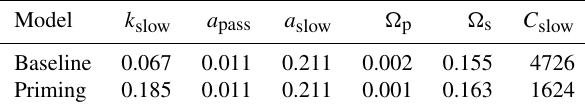
Table 5. Effect of priming on key soil process coefficients. Coeffi- cient k slow is the decomposition coefficient for the slow SOM pool (yr − 1 ); a pass is the reburial fraction of the passive SOM (i.e., the fraction of passive SOM reenters passive SOM); a slow is the reburial fraction of the slow SOM; (cid:127) p is the burial coefficient for plant ma- terials entering the passive SOM pool; (cid:127) s is the burial coefficient for plant materials entering the slow SOM pool; and C slow is the total carbon stock of the slow SOM pool (gCm − 2 ). Both models assume a variable wood N:C